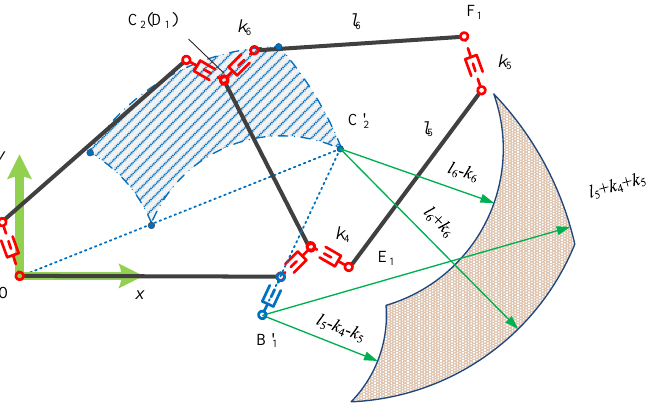
Figure 8. The positional analysis for multi-loop structures.